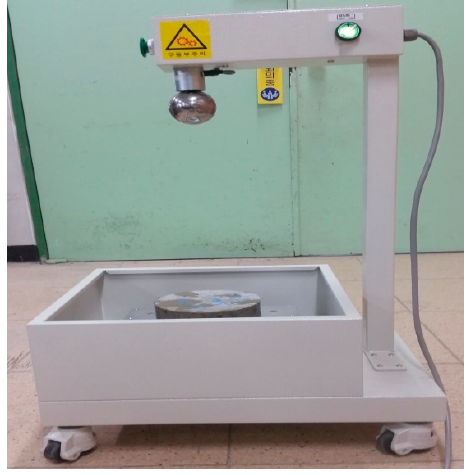
Figure 5. Impact test set-up.